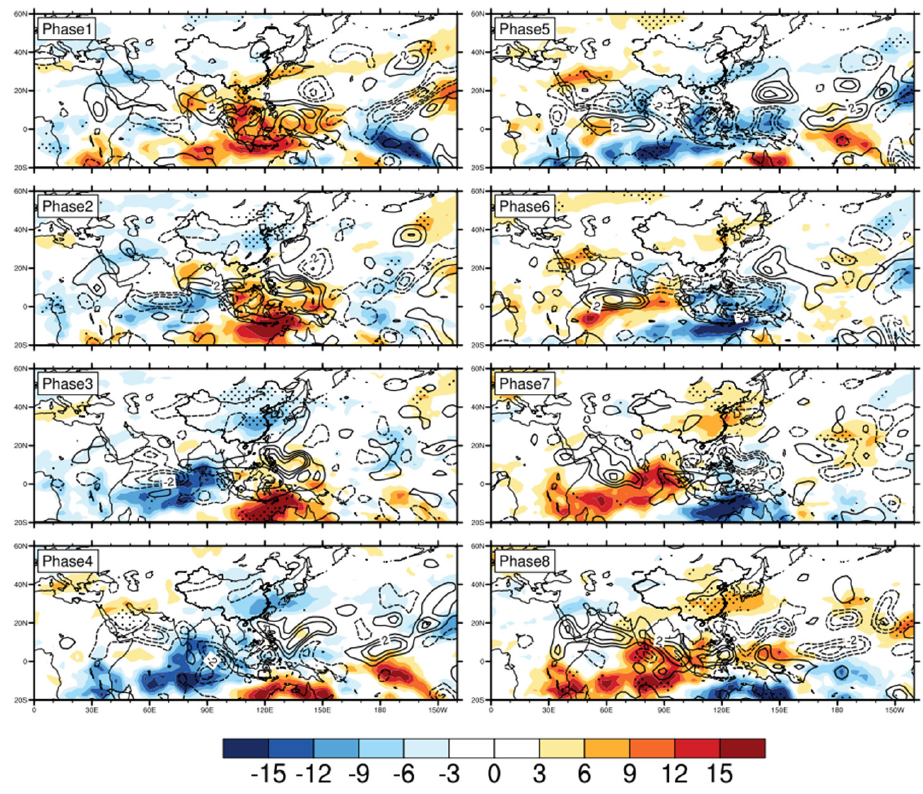
Figure 13. The 30–60-d filtered OLR anomaly field (shading, unit: W · m − 2 ) and 500-hPa omega anomaly field (contours, unit: hPa·s − 1 ). (Dotted areas are OLR passing 95% significance test.)